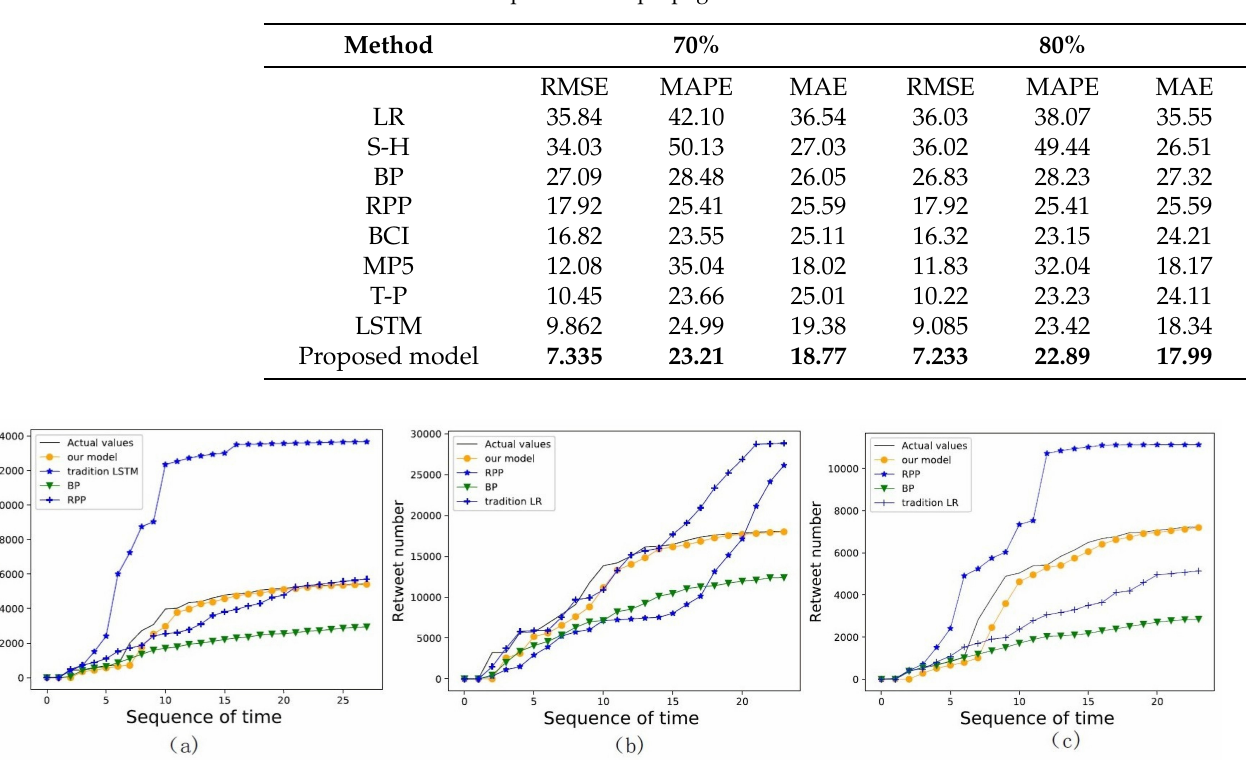
Table 7. The results of experiment on propagation trends.